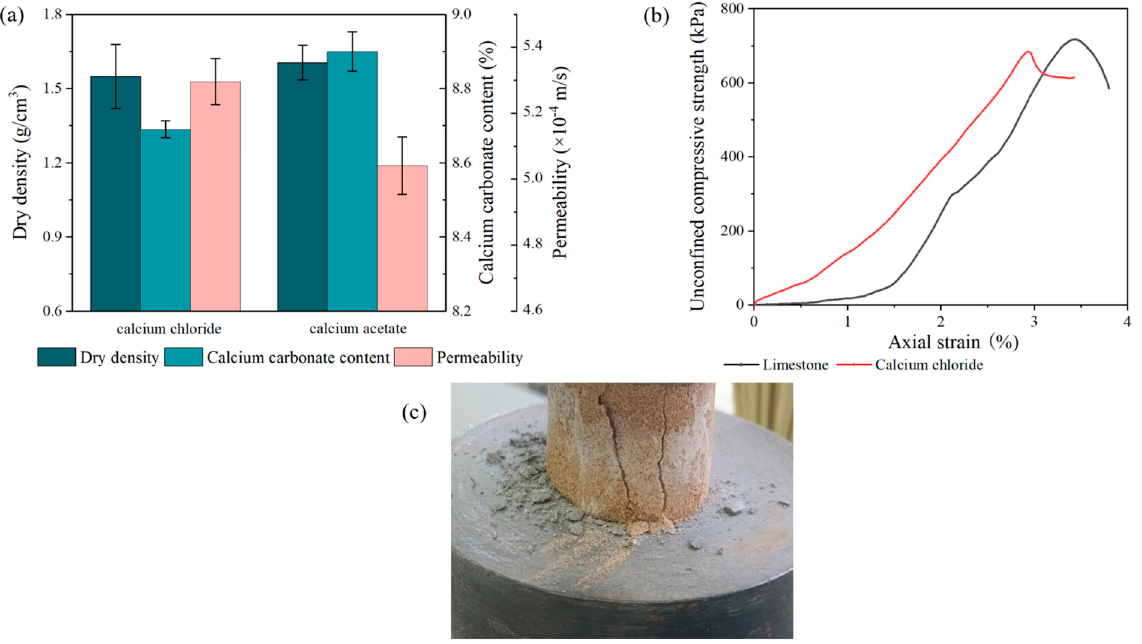
Figure 4. Macromechanical behavior of sand cured using two sources of calcium. ( a ) Dry density, calcium carbonate content, and permeability, ( b ) stress-strain curves of samples after grouting, and ( c ) sand column after stress failure.